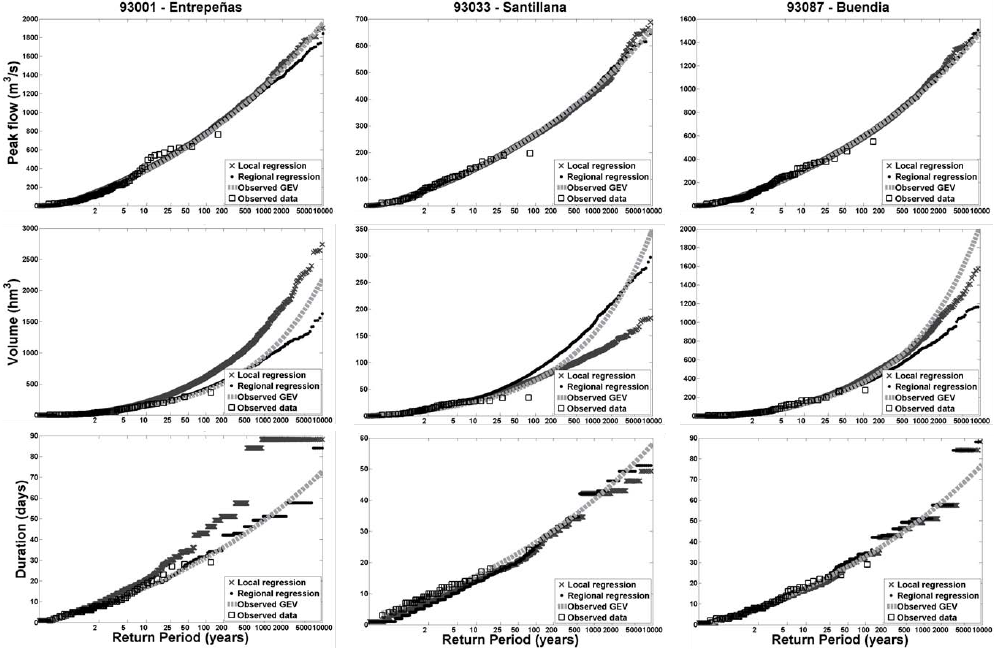
Fig. 3. Comparison between the observed and synthetic peaks, volumes and durations from the local and regional regressions fitted in the three case studies.